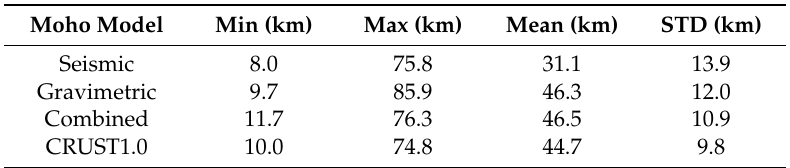
Table 2. Statistics of the Moho models.